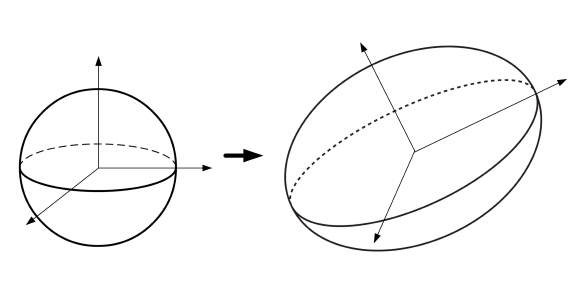
Figure 5: Distortion of the normalized moment/force sphere.